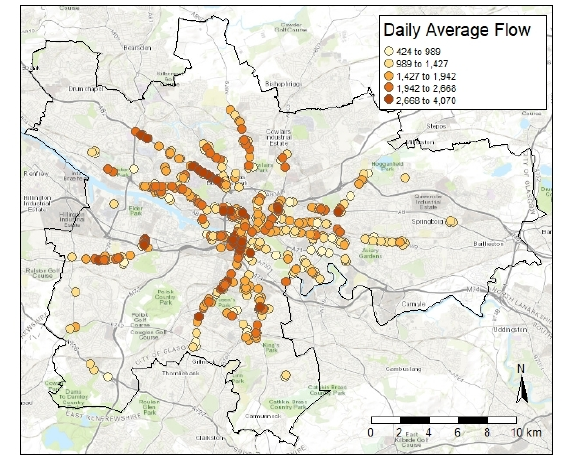
Figure 5 . Spatial distribution of daily average traffic flow in Glasgow.